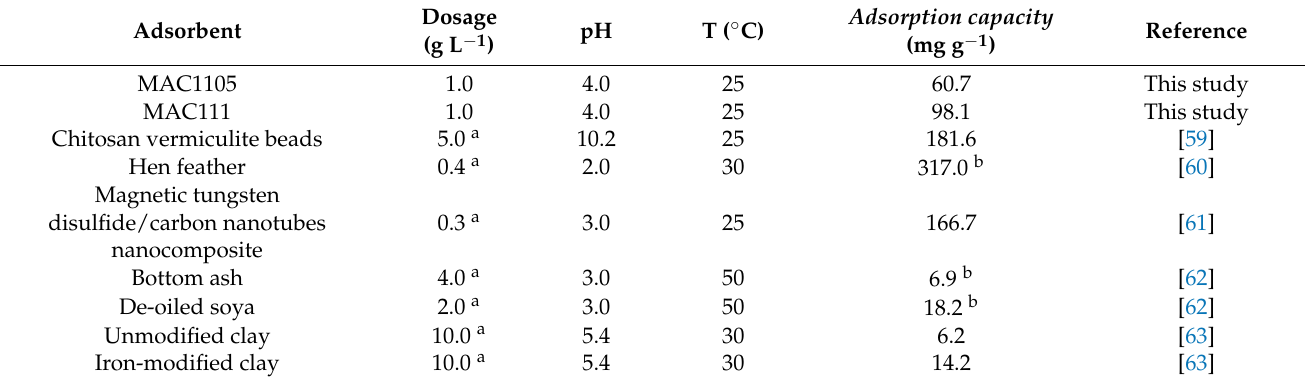
Table 5. Adsorption capacities of different adsorbents for BB dye adsorption.